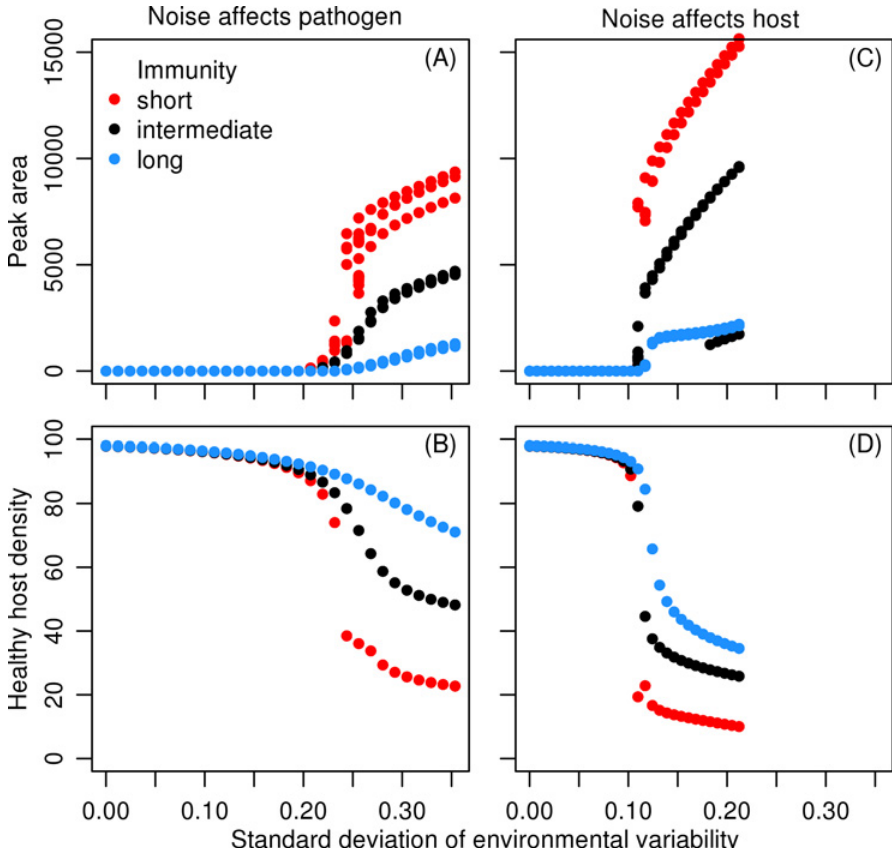
Fig 1. The effect of periodic variation. The effect of the variance of periodic environmental variation on the severity of outbreaks and healthy host density. Left panels (A) and (B): variations affect pathogen growth rate r p . Right panels (C) and (D): variations affect 50% infective dose ID 50 . Top panels (A) and (C) show the peak areas (outbreak severities). Bottom panels (B) and (D) show healthy host (S + R) density minima. Colours red, black, and blue show results on rapid, intermediate, and slow immunity loss rates, respectively. Under short immunity, interaction with a small cyclic range of pathogen growth rates (see Methods) causes three different peak areas per value, corresponding to three differently shaped infection cycles. See Table 1 for model